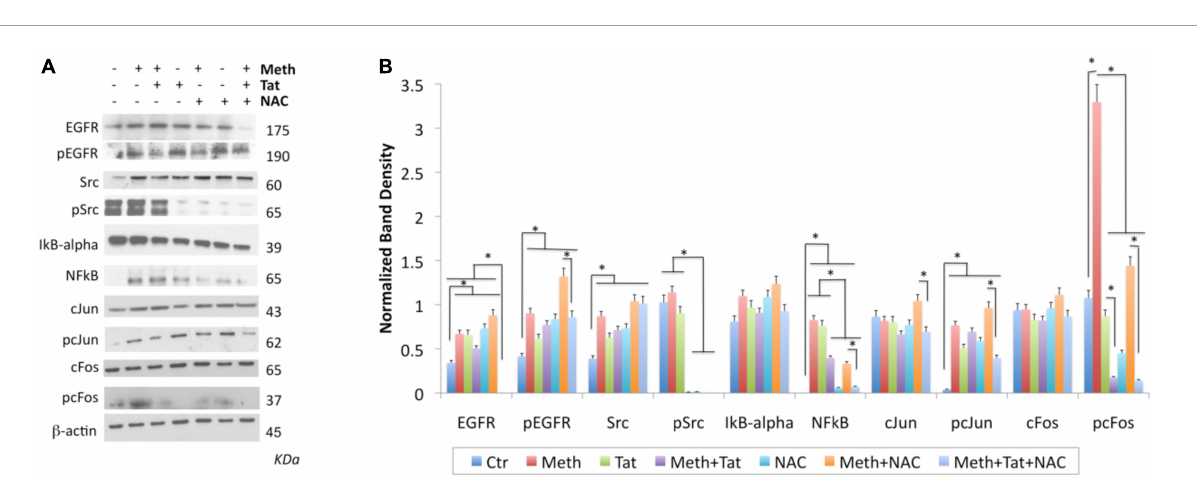
FIGURE9 Changes in transcription factors activated by Meth. Western blot was used on protein extracts of THP1 cells stimulated for 2 h with Meth (60 uM), Tat (10 ng/ml) and/or NAC (1 uM) to examine changes in the levels of EGFR, pEGFR, SRC, pSRC, IkB-alpha, NFkB, cJUN, pcJUN, cFOS, and pcFOS, using specific antibodies. (A) Representative western blots showing all the analyzed transcription factors and the examined conditions. Molecular weight of each band is shown on the right side of the panel. (B) B-actin- normalized band density calculated in Fiji Image J, from 3-4 independent experiments. * p < 0.01 in indicated comparisons. ANOVA followed by Bonferroni’s